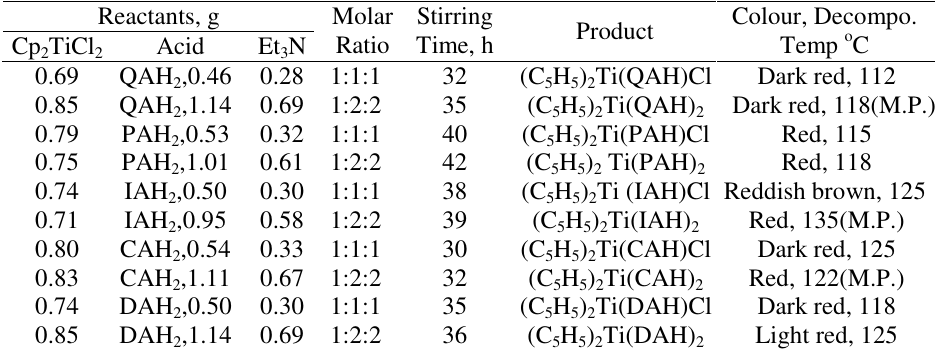
Ti Cl with pyridinedicarboxylic Acids 2 2